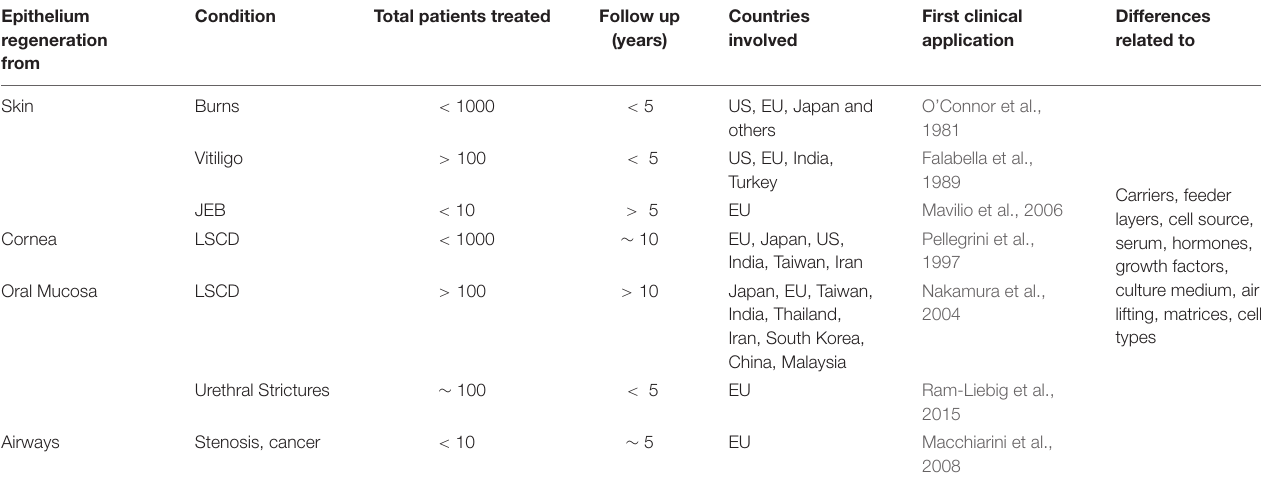
TABLE 1 | Summary of published clinical applications involving autologous cultured epithelia engraftment.